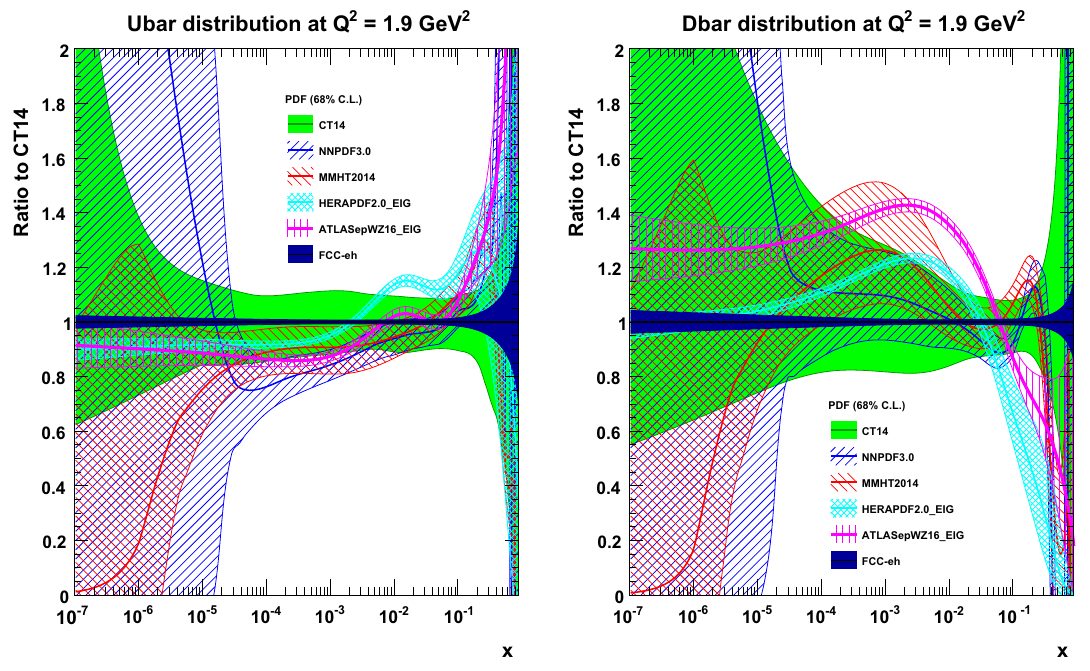
Fig. 5.11 Sea quark distributions at Q 2 = 1 . 9 GeV 2 as a function of Bjorken x , presented as the ratio to the CT14 central values. The FCC-eh PDF values are adjusted to the central value of CT14 and the uncertainties correspond to the dark blue